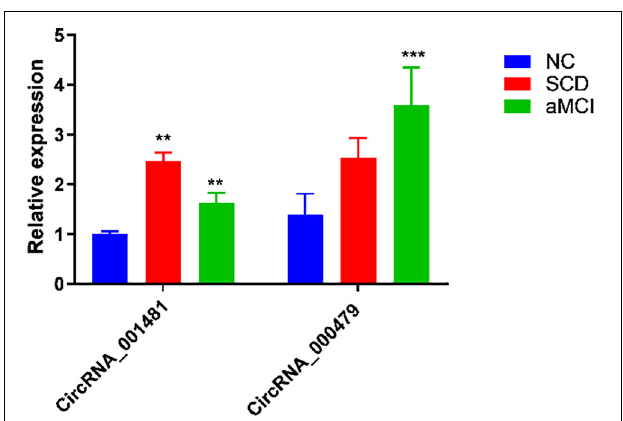
FIGURE 3 | RT-qPCR analysis of hsa_circRNA_001481 and hsa_circRNA_000479. The relative expression of SCD and aMCI are significantly upregulated in hsa_circRNA_001481 as compared to NC. The relatively higher expression in aMCI is also observed in hsa_circRNA_000479. The values are the average values of three independent experiments (** P < 0.01, *** P < 0.001).